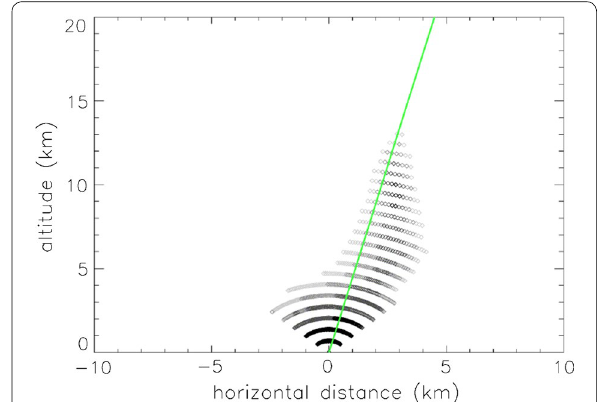
Fig. 2 Distribution of the RASS echoing region that satisfies the Bragg condition. The shading depth is changed as a function of the distance between the return point of the RASS echo on the ground and the center of the EAR antenna. The figure shows four levels of the shading for a distance up to 80 m with a step of 20 m. The green line indicates the antenna beam with the zenith angle at 13°